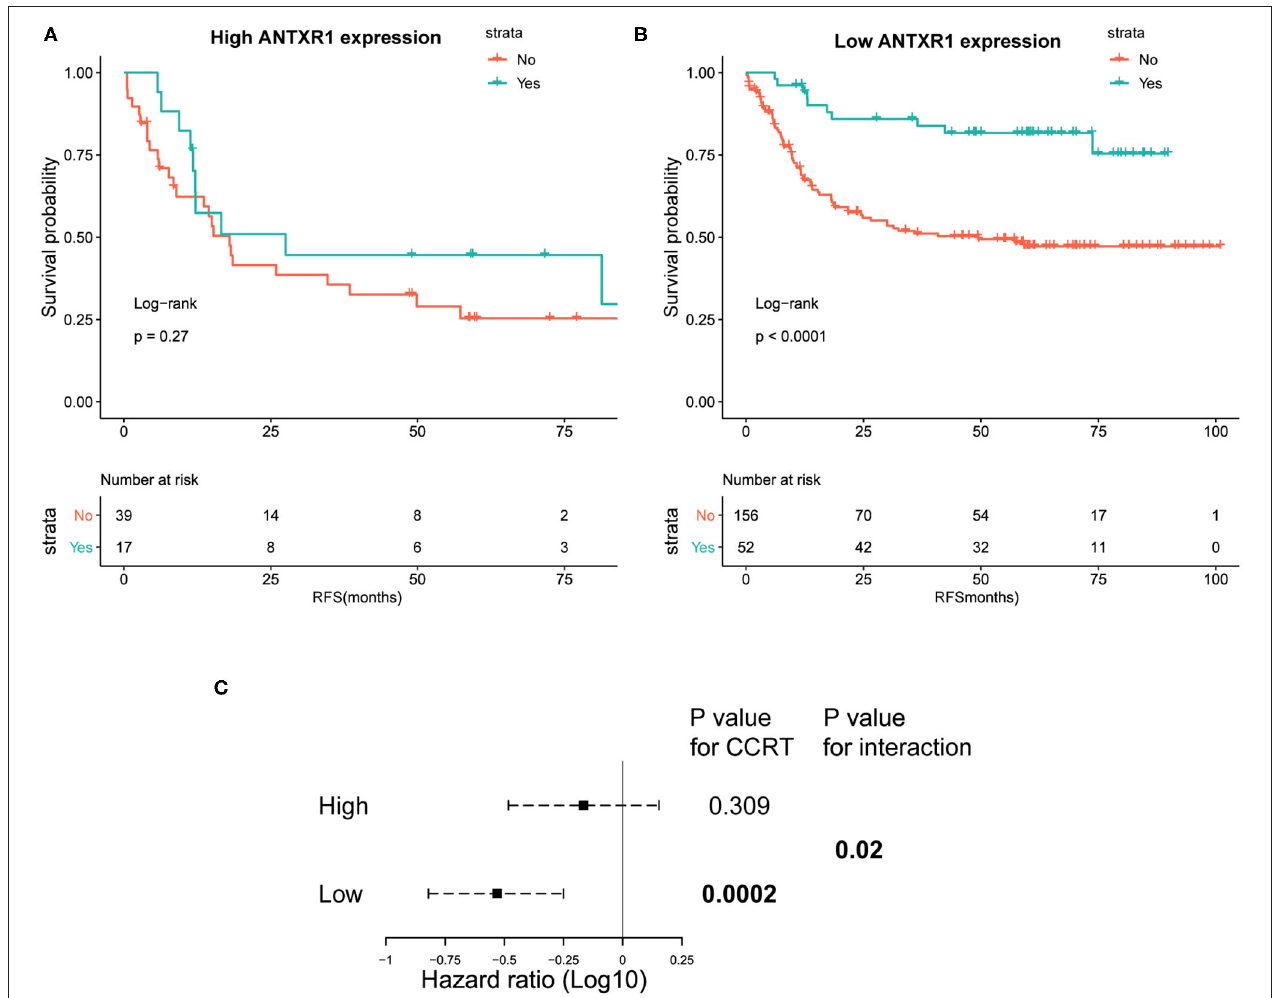
FIGURE 7 | Kaplan–Meier plots of recurrence-free survival (RFS) analysis. (A,B) Kaplan–Meier plots of RFS among patients who received CTX and those who did not for high and low ANTXR1 expression group. Log-rank test was utilized to determine the P -values. (C) Interaction of ANTXR1 expression with CTX in patients with gastric cancer. The Cox proportional hazards regression model was employed to analyze the interaction between ANTXR1 expression and CTX. CTX, adjuvant